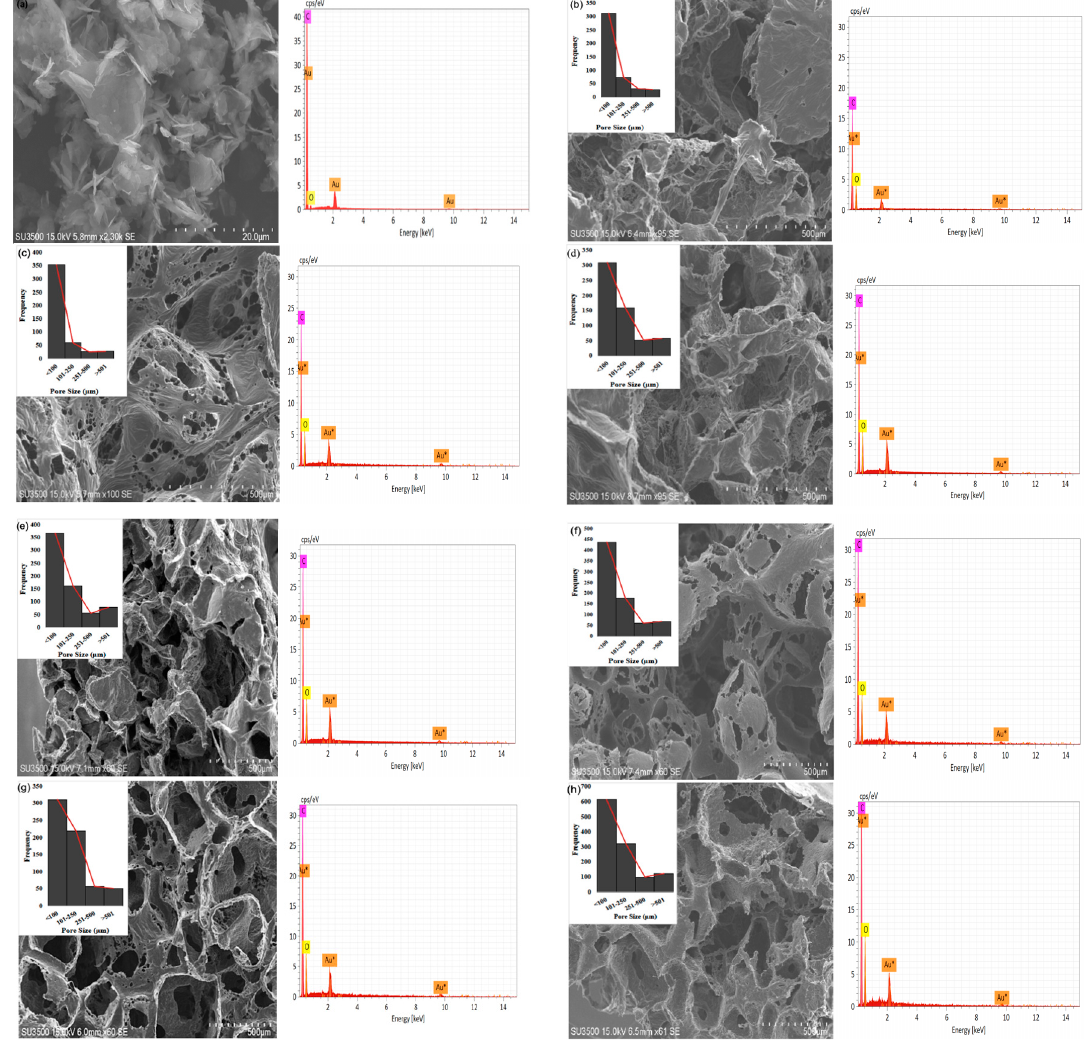
Figure 3. SEM of morphology, pore distribution, and SEM-EDS of scaffold: ( a ) graphene; ( b ) PCL; ( c ) 0.5 wt% G; ( d ) 1 wt% G; ( e ) 1.5 wt% G; ( f ) 2 wt% G; ( g ) 2.5 wt% G; ( h ) 3 wt% G.